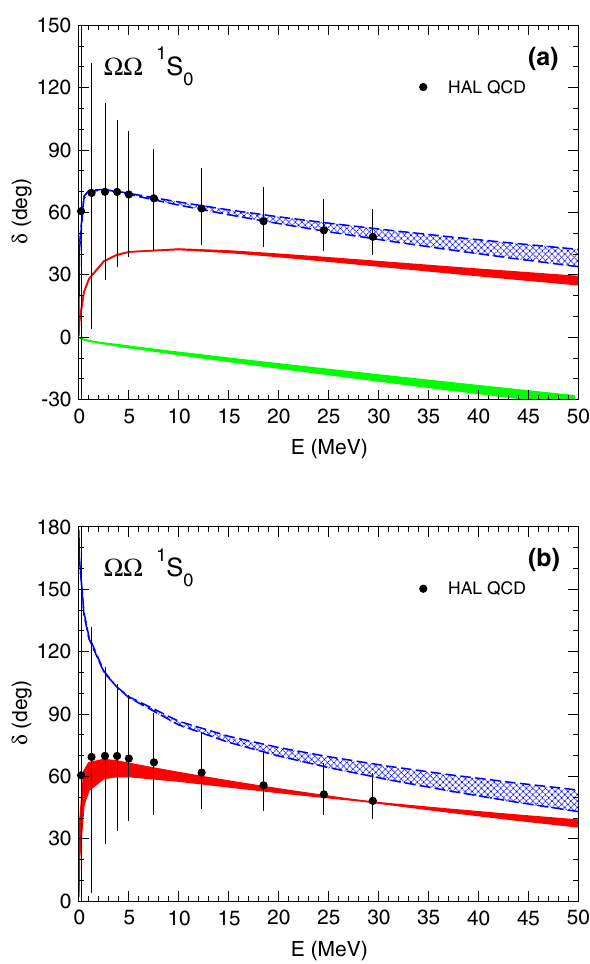
Fig. 1 ΩΩ 1 S 0 phase shift as a function of the kinetic energy in the center-of-mass system. The result of the HAL QCD collaboration is taken from Ref. [19]. Fits to the central value ( a ) and maximal value ( b ) of the lattice simulation are shown by hatched (blue) bands, corresponding to cut-off variations between 500 and 700 MeV. Corre- sponding results at the physical point are indicated by dark (red) bands. The gray (green) band is the result based on the lattice simulation by Buchoff et al.